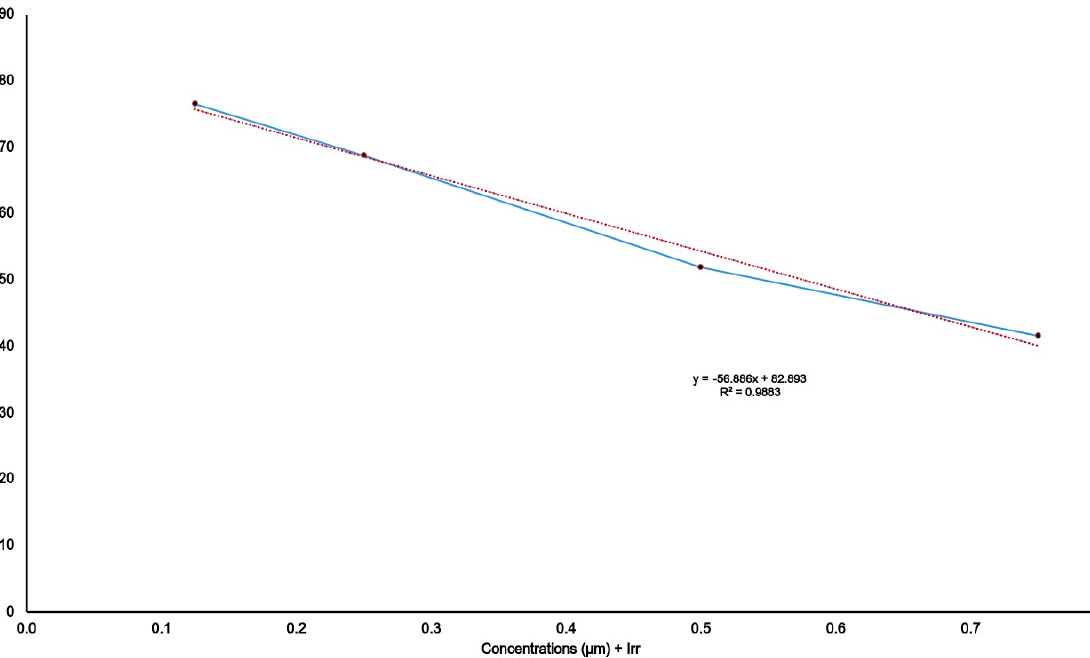
Figure 7. Trypan blue viability: IC50 concentration calculation at which Caco-2 cells grown were inhibited by 50% after 24 h of incubation with ALCIPcTS41. The half inhibitory concentration (IC50) which was found to be (0.58 µ M) for AlClPcTS41 mediated PDT was calculated by plotting the linear regression (y = − 56.886x + 82.893), with a regression (R 2 = 0.9883) (red colour), between the different concentration of AlClPcTS41 and % inhibition in Caco-2 cells (blue colour). Calculated from the equation of AlClPcTS41 concentration in relation to the survival index. (SE − standard